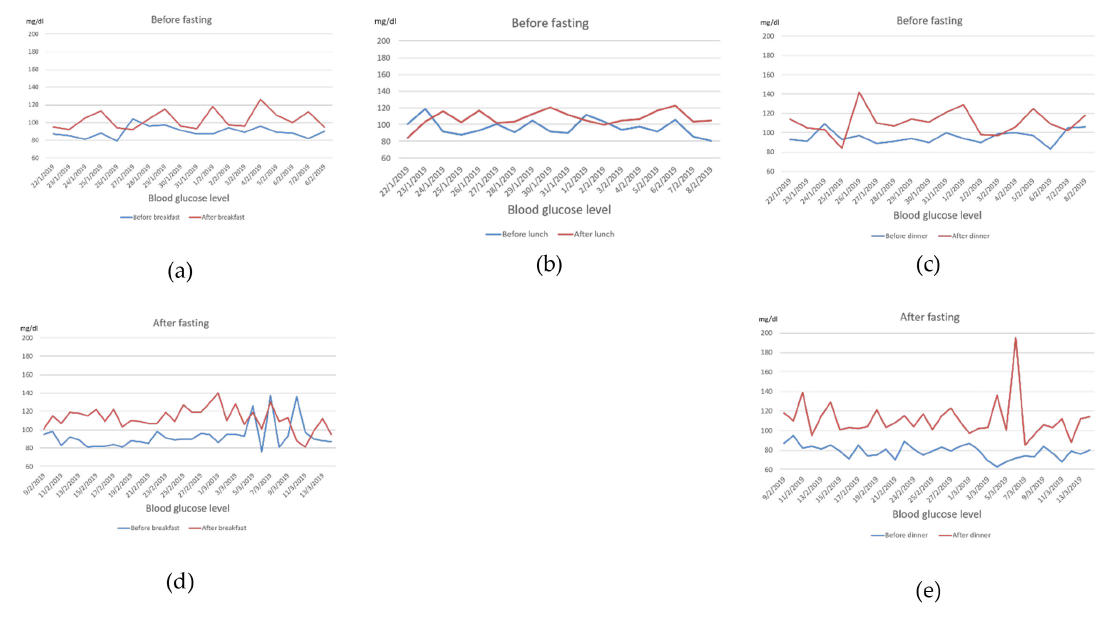
Figure 3. Maternal blood glucose level before and 2 after meals within the context of dietary modifications, exercise ( a – c ), and after intermittent fasting ( d , e ) in late pregnancy. Dietary modifications were implemented during the 26th week and intermittent fasting practice started at the 30th week and continued until the end of the pregnancy. The lunch meal was dropped after the commencement of intermittent fasting.